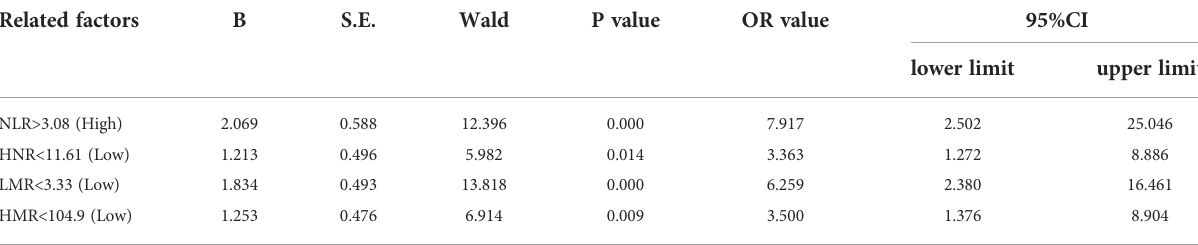
TABLE 5 Univariate Logistic regression analysis of NLR, LMR, HNR, and HMR (two categories) in predicting NSCLC transfer. Related factors